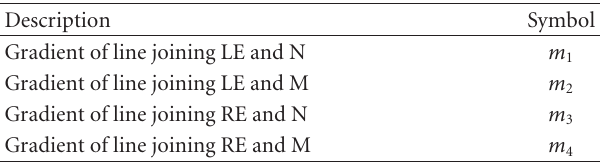
Table 2: Gradient components of angle